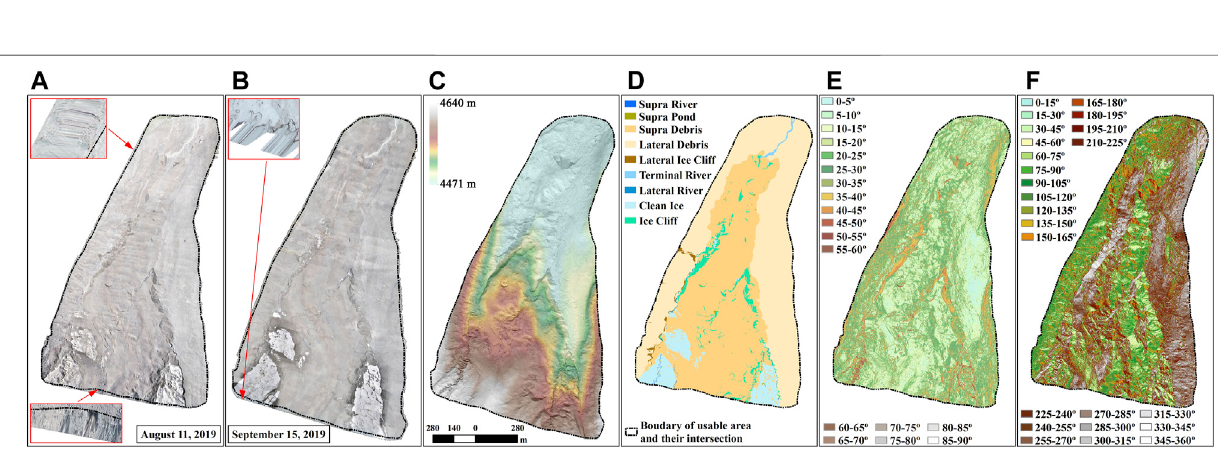
Frontiers in Earth Science |